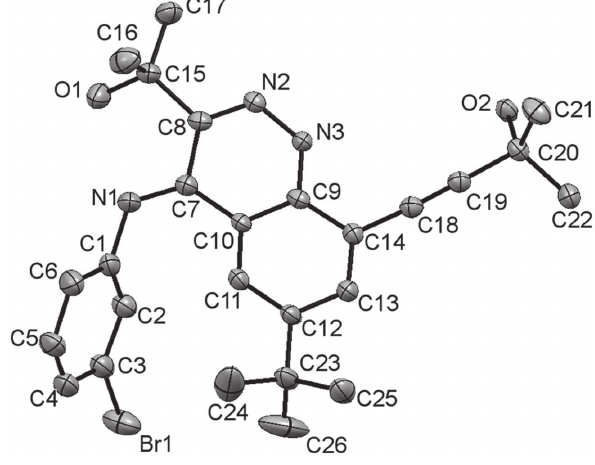
Table 1: Data collection and handling.